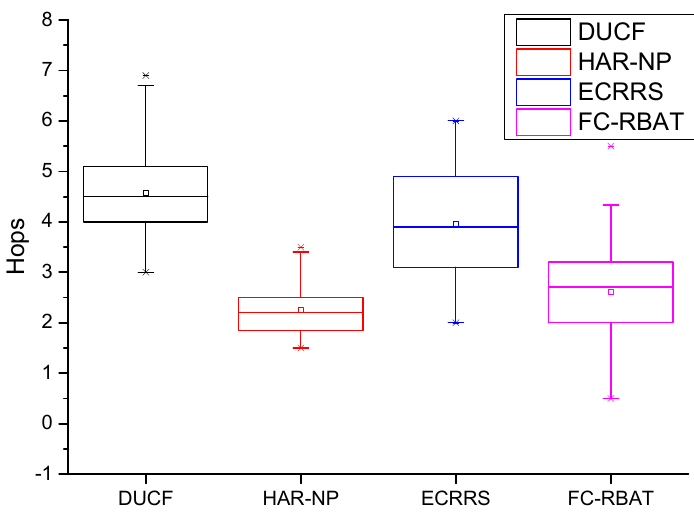
Figure 8. Comparison of the average number of network hops.